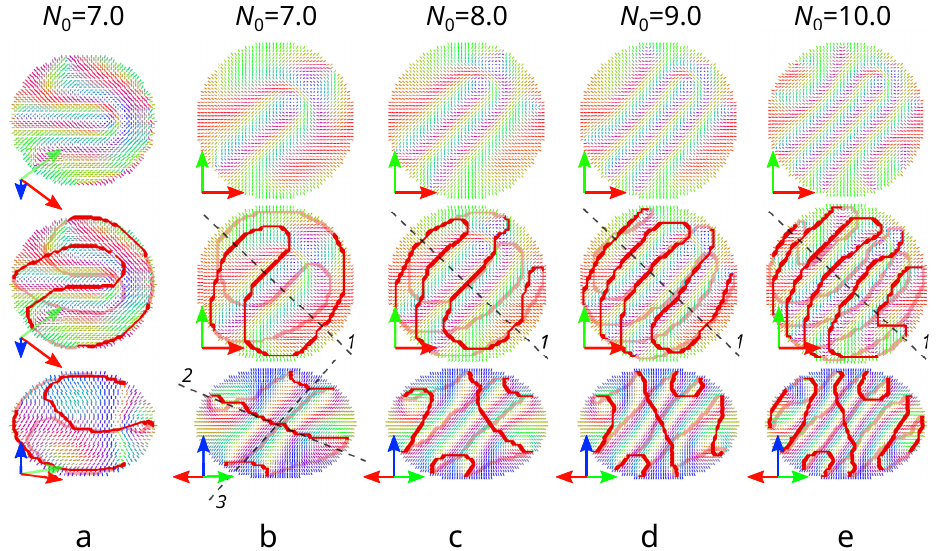
Figure 3. Director distributions in CLC droplets with λ + 1/2 -disclination at N 0 = 7.0 ( a , b ), 8.0 ( c ), 9.0 ( d ) and 10.0 ( e ). ( a ) Director distributions in the plane ( 2 ) perpendicular to the λ + 1/2 -disclination ( top and middle lines ) and in the plane ( 3 ) through the λ + 1/2 -disclination ( bottom line ). ( b – e ) Di- rector distributions in the equatorial plane—top view ( top and middle lines ); and in the plane ( 1 ) perpendicular to cholesteric layers—side view ( bottom line ). Red lines depict defect